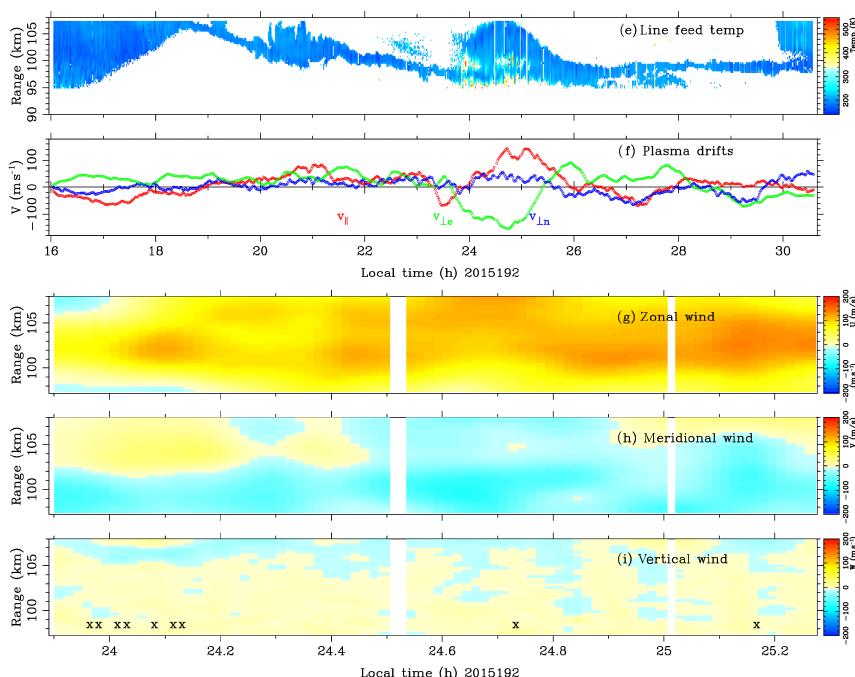
Figure 4. Detailed examination of the Arecibo dataset from 11/12 July 2015. The focus here is on the second patchy sporadic E layer. Panels (e) – (i) are described in the